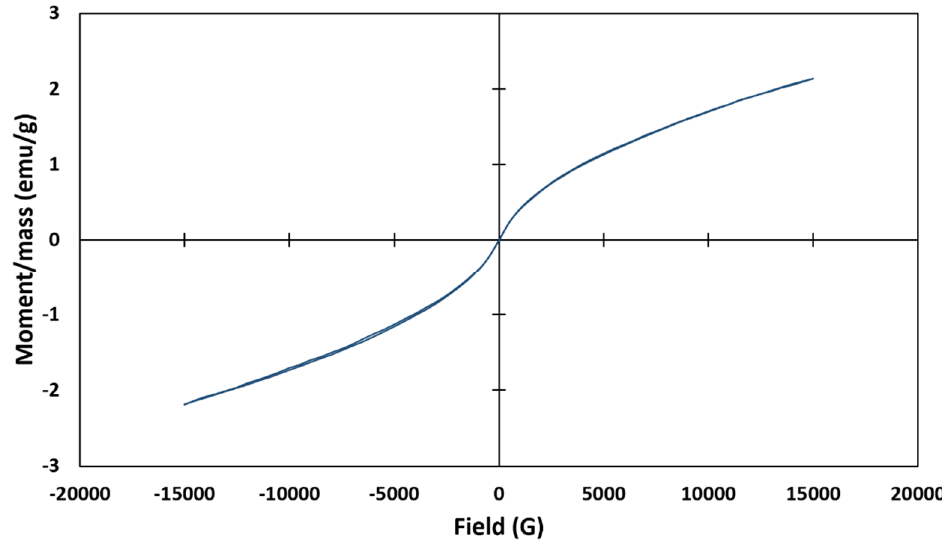
Figure 5. Magnetization curve of MMT/CR/Fe 3 O 4 -NCs.